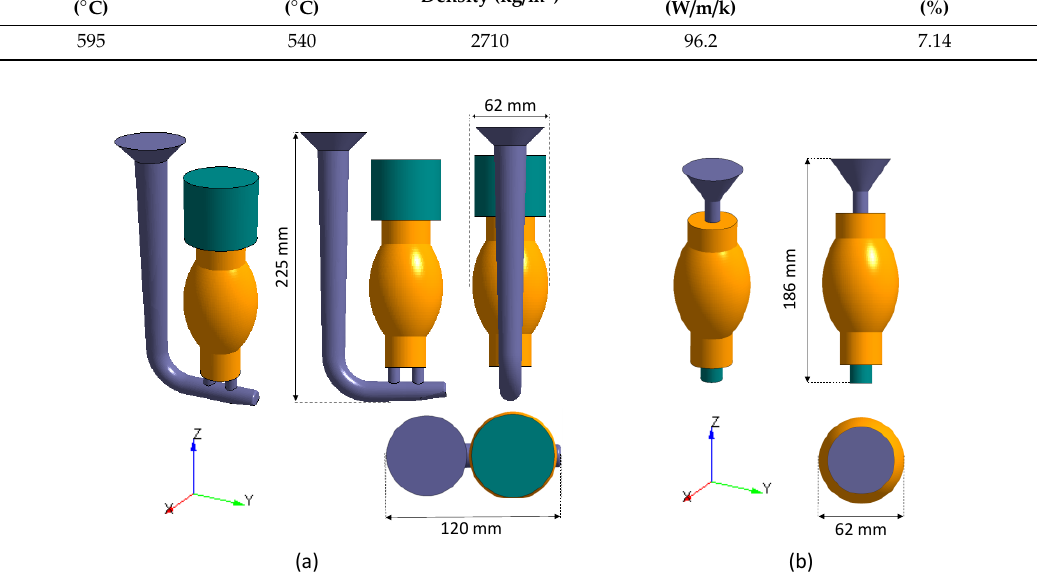
Figure 2. ( a ) 3D model for binder jetting (BJ) gravity-pouring casting system. ( b ) 3D model for BJ vacuum-assisted casting system.